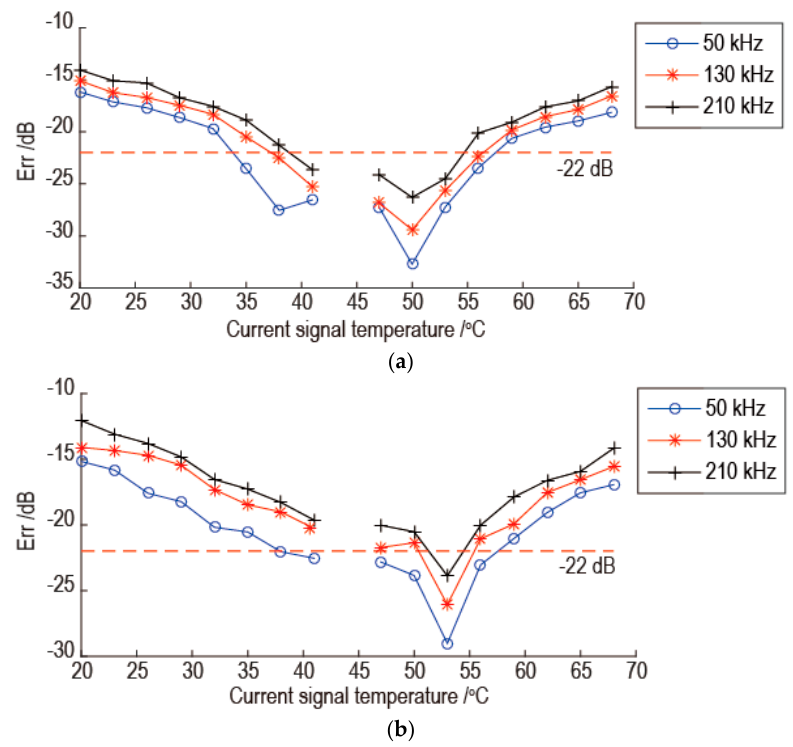
Figure 9. The temperature compensation results using 44 °C baseline signal and 50 °C, 53 °C reference signals: ( a ) The result using 50 °C reference signal; ( b ) The result using 53 °C reference signal.